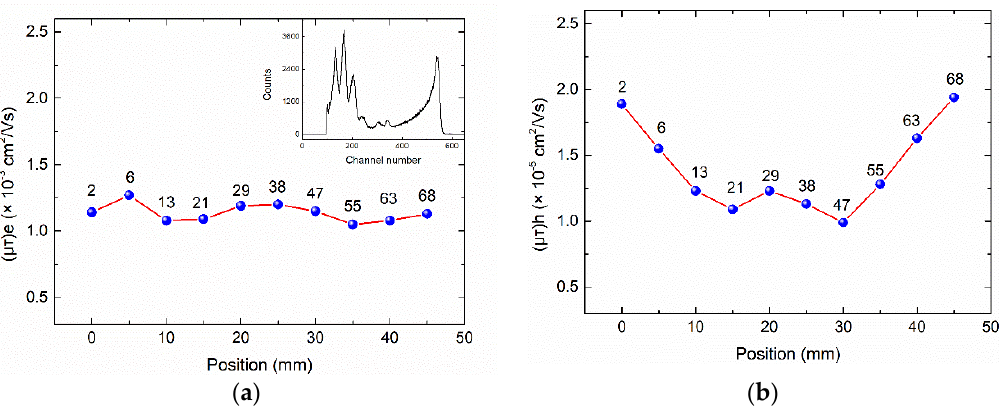
Figure 7. Mobility-lifetime products of detectors from the same column: ( a ) ( μτ ) e and ( b ) ( μτ ) h values. The inset in (a) shows a typical radiation response spectrum for detector No. 68. The numbers above the data points in the figures show the corresponding detector number in Figure 6a.